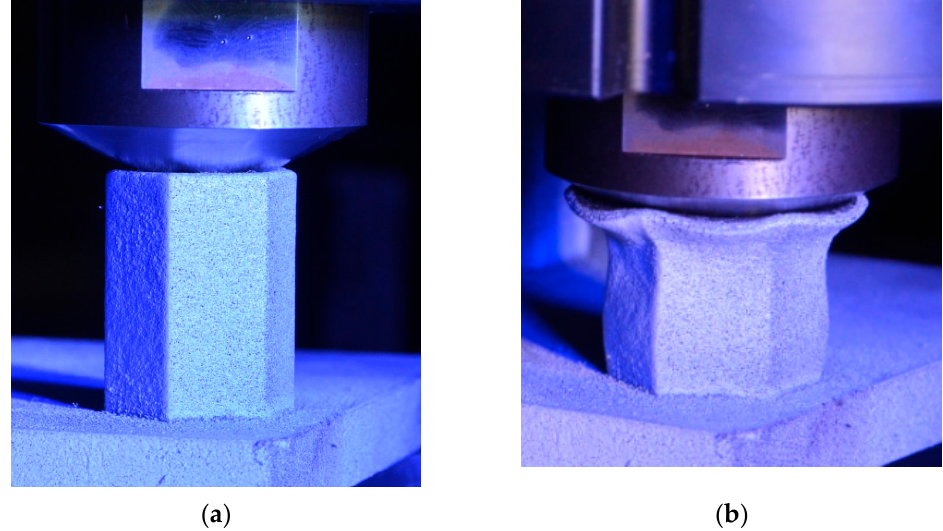
Figure 19. Setup of compression test of the honeycomb structure with a stochastic pattern for defor- mation tracking using DIC ( a ) before the test, ( b ) after the test. deformation tracking using DIC ( a ) before the test, ( b ) after the